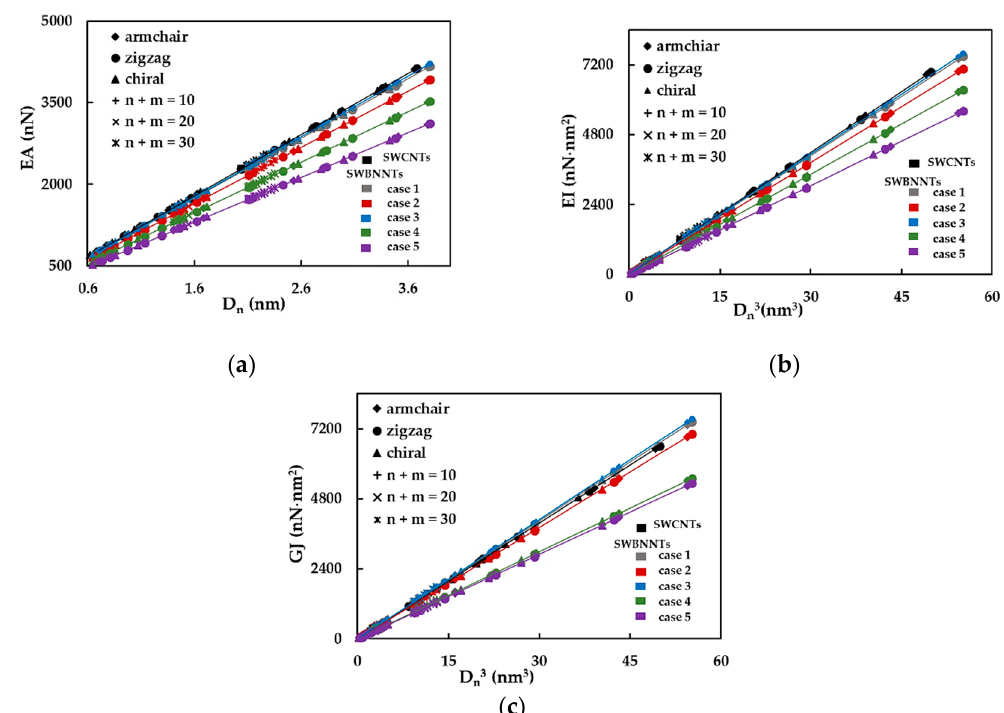
Figure 4. The evolution of rigidities as a function of the nanotube diameter, D n , for non-chiral and chiral SWBNNTs, considering five different cases of input parameters, and for SWCNTs with the same chiral indices in: ( a ) tension, EA, ( b ) bending, EI, and ( c ) torsion, GJ. Table 5. The fitting parameters α (cid:2886)(cid:2898) , β (cid:2886)(cid:2898) and γ (cid:2886)(cid:2898) for SWBNNTs, considering the five cases of input values shown in Table 3.